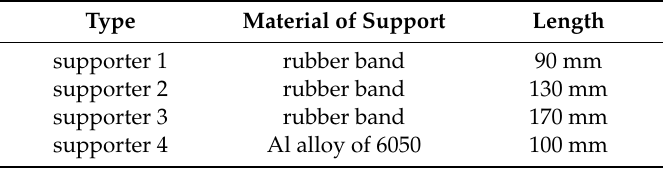
Table 3. Support parameters.